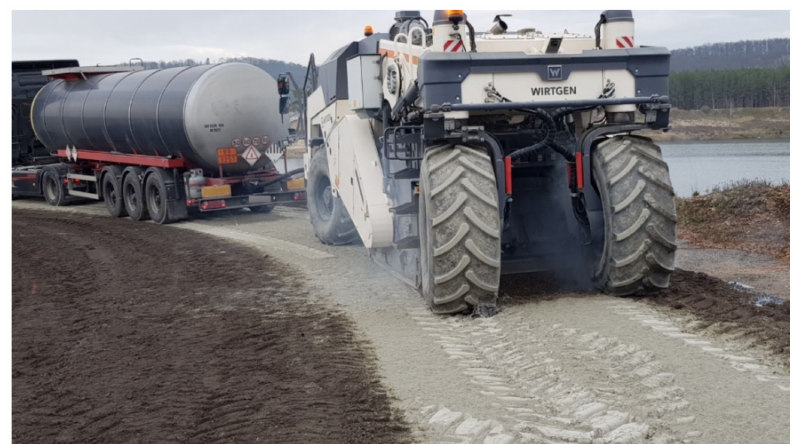
Figure 4. Preparation of the recycled mixture under field conditions using the “in situ” method [P. Buczy´nski].